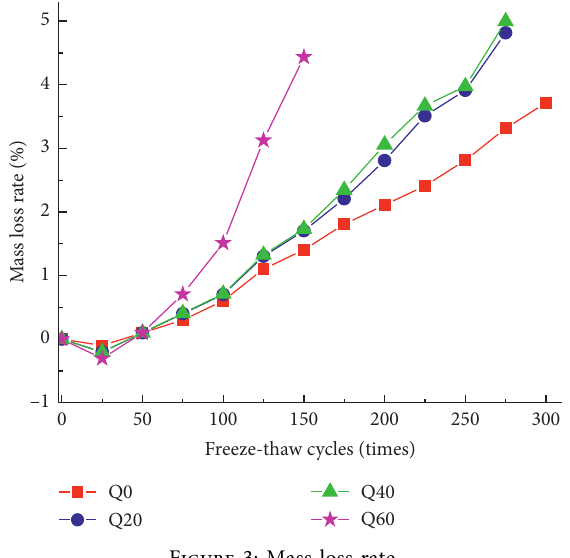
Figure 3: Mass loss